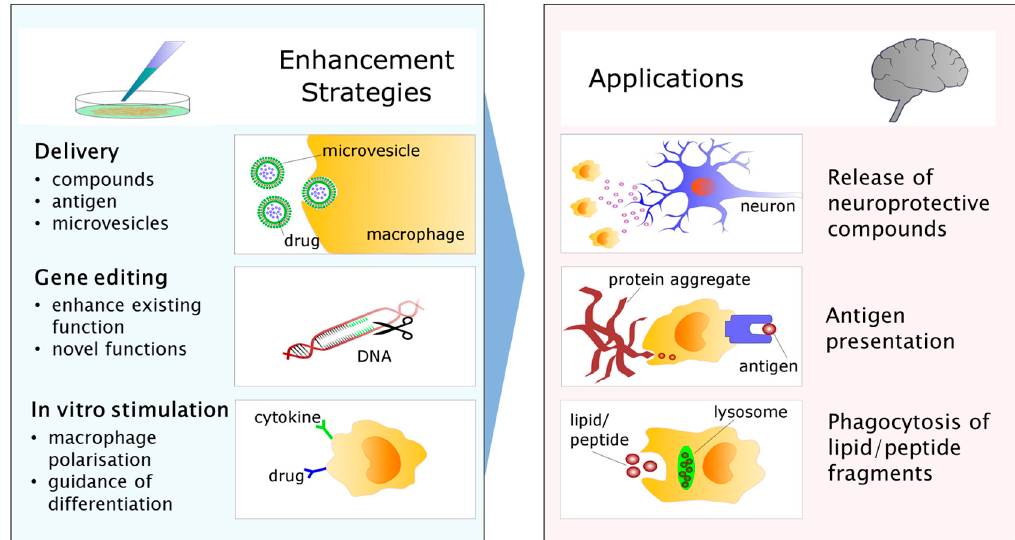
Figure 3. Strategies for enhancing myeloid cell therapy for the CNS. The phagocytic capacity of myeloid cells may be adapted for use as delivery vehicles for compounds, antigens, or microvesicles loaded with therapeutic substances destined for the brain. Pictured is a macrophage in the process of taking up drug-loaded nanoparticles intended for delivery into the CNS. Gene editing enables the up/downregulation of existing functions to enhance protective, or eliminate damaging responses to disease. It is also possible to introduce expression of enzymes not usually present in these cells through this process. Another strategy for guiding myeloid cell-based therapies in the CNS involves in vitro manipulation of polarisation or differentiation, for example with cytokines or drugs known to guide the cells into a more neuroprotective phenotype. As a result of in vitro manipulation, myeloid cells returned to the circulation may then be better capable of ameliorating brain pathology by one of several mechanisms. For example, CNS-infiltrating myeloid cells may be better equipped to release compounds with growth or survival-promoting effects on nearby diseased neurons. Alternatively, it may be possible to enhance the capacity of infiltrating cells to present brain-derived antigens to the adaptive immune system, thus enhancing clearance of unwanted protein products. Myeloid cells may also be used to enhance the clearance of excess waste or diseased tissue independently via phagocytosis.